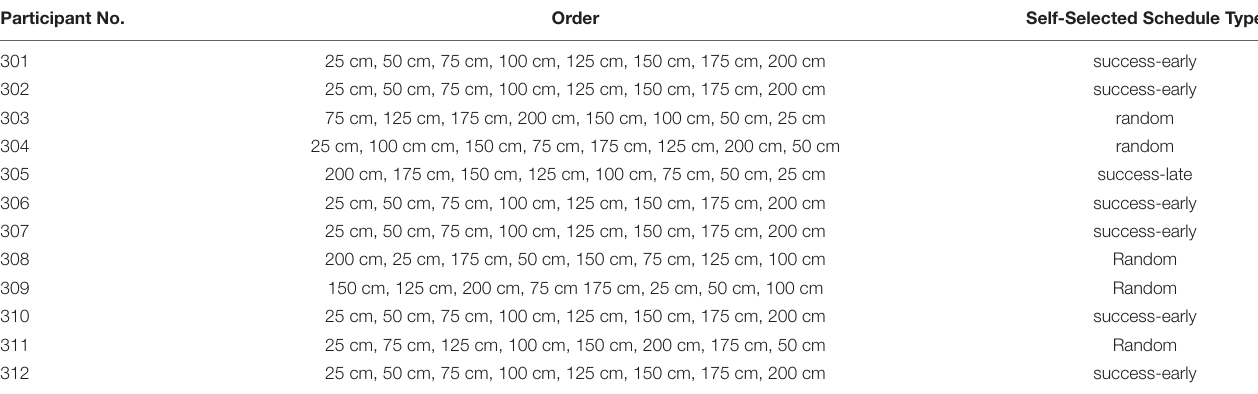
TABLE 3 | Self-control group participants’ self-selected practice-distance order during the acquisition phase (Day 1). Participant